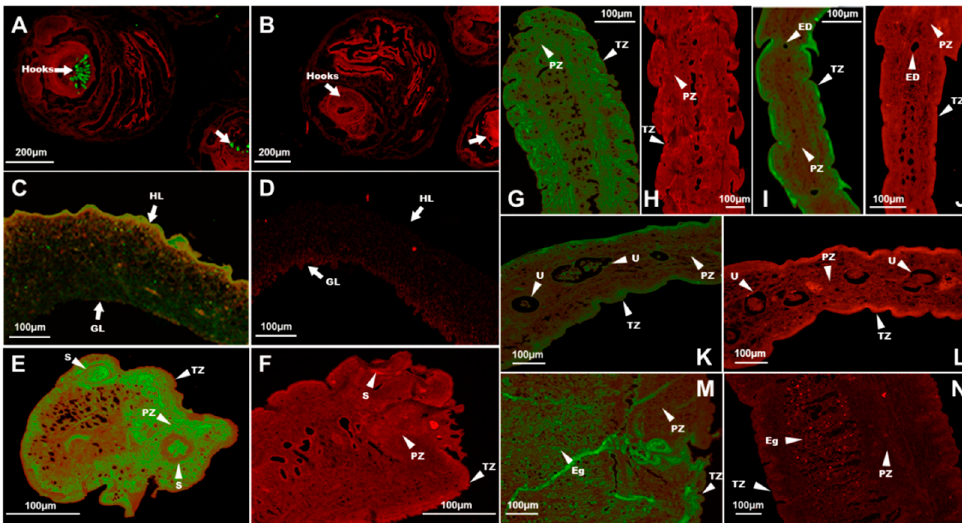
Figure 7. Immunofluorescence localization of TmAnxB3 in T. multiceps . Against the red background, the green fluorescent color shows the location of the native TmAnxB3 protein: ( A ) protoscolex with positive serum; ( B ) protoscolex with negative serum; ( C ) cyst wall with positive serum; ( D ) cyst wall with negative serum; GL, germinal layer; HL, horny layer; ( E ) scolex with positive serum; ( F ) scolex with negative serum; ( G ) neck with positive serum; ( H ) neck with negative serum; ( I ) immature proglottids with positive serum; ( J ) immature proglottids with negative serum; ( K ) mature proglottids with positive serum; ( L ) mature proglottids with negative serum; ( M ) gravid proglottids with positive serum; and ( N ) gravid proglottids with negative serum. Abbreviations: S, suckers; GL, germinal layer; HL, horny layer; TZ, tegument zone; PZ, parenchymatous zone; ED, excretory duct; U, Uterus; Eg, eggs.